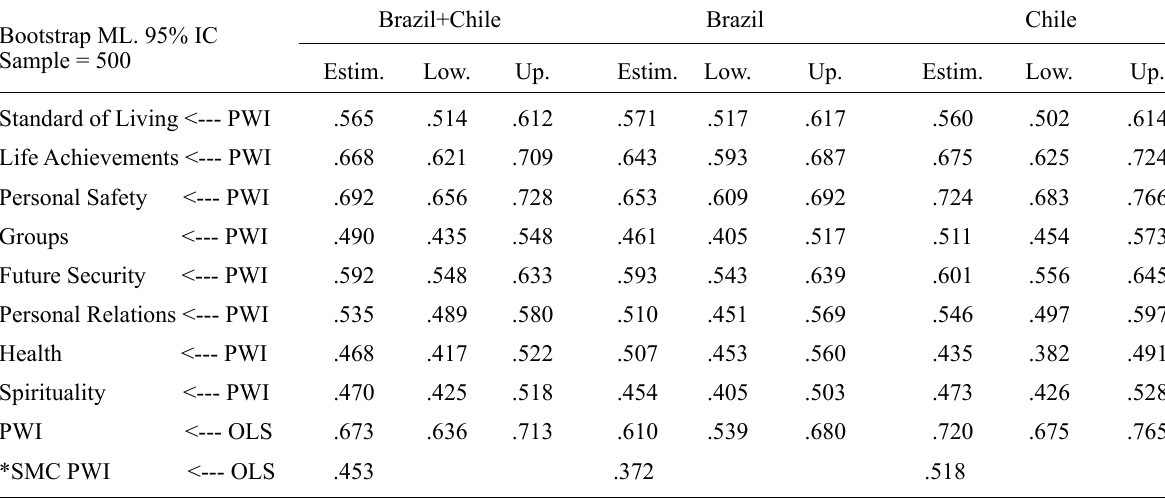
Standardized Estimations – PWI 8 –